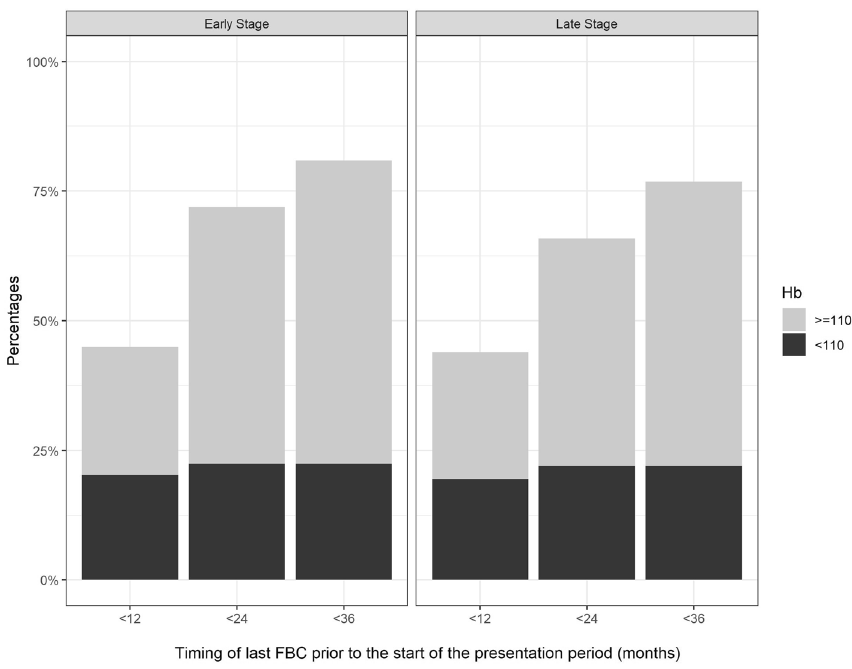
Figure 2. The cumulative percentage prevalence of blood count checks in the 12, 24 and 36 months prior to the diagnosis of CRC in the IDA group, sub-divided according to the tumour stage (early/late) and Hb result (g/l).